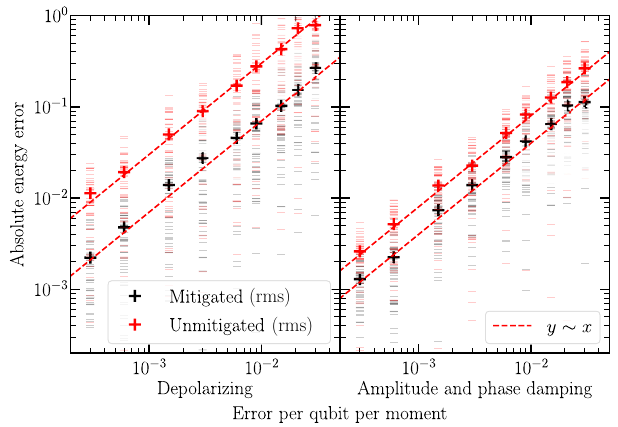
FIG. 4. Mitigation of a four-qubit VHA circuit via verified phase estimation. Left: error in estimation of the energy of ran- dom states generated by the quantum approximate optimization ansatz in the critical phase of the transverse-field Ising model [Eq. (62)] under a uniform depolarizing channel. Right: error in the same estimation, but this time under an amplitude and phase damping model. In both plots, the rms error (crosses) is calculated over 50 different estimations for each error rate (with randomly chosen ansatz parameters) using either standard partial state tomography (red) or using verified control-free phase esti- mation. Individual data points (dashes) are additionally shown. For reference, dashed lines showing linear (red) dependence on the gate error rate are